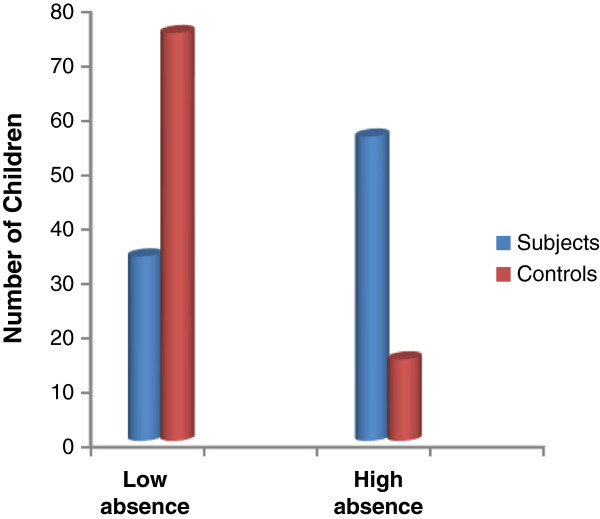
Distribution of subjects and controls by degree of school absence.